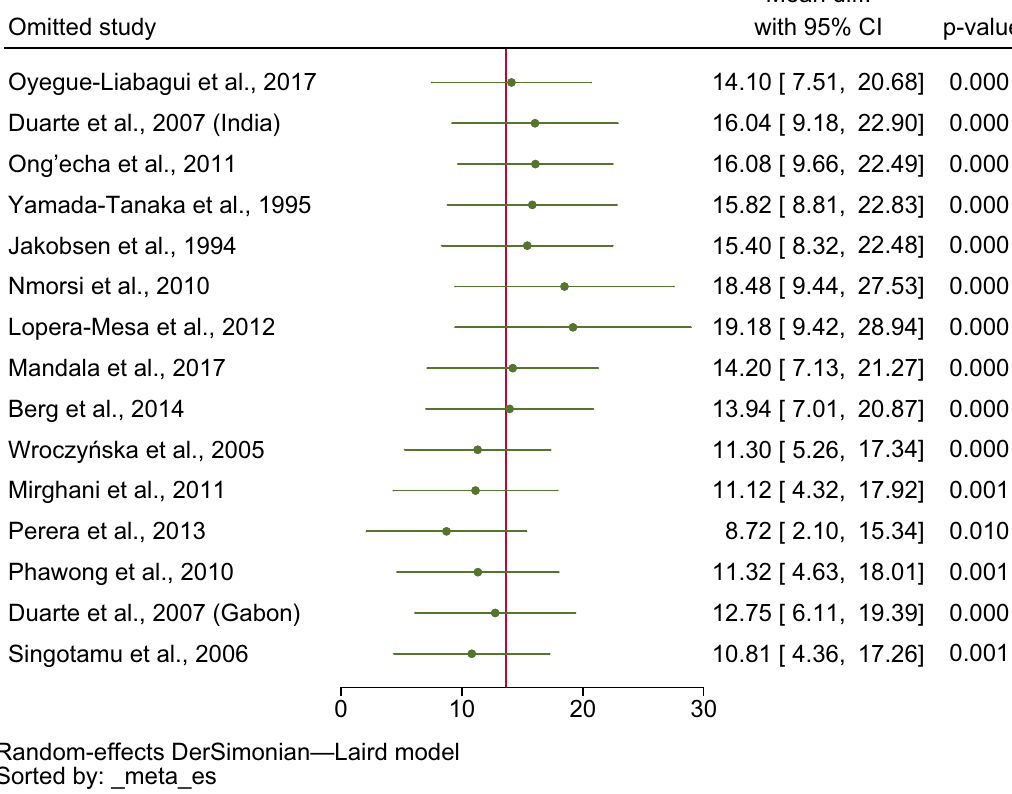
Figure 7. Forest plot demonstrating the sensitivity analysis (leave-one-out method) of the pooled MD of INF-γ levels between patients with severe and uncomplicated malaria . CI confidence interval.